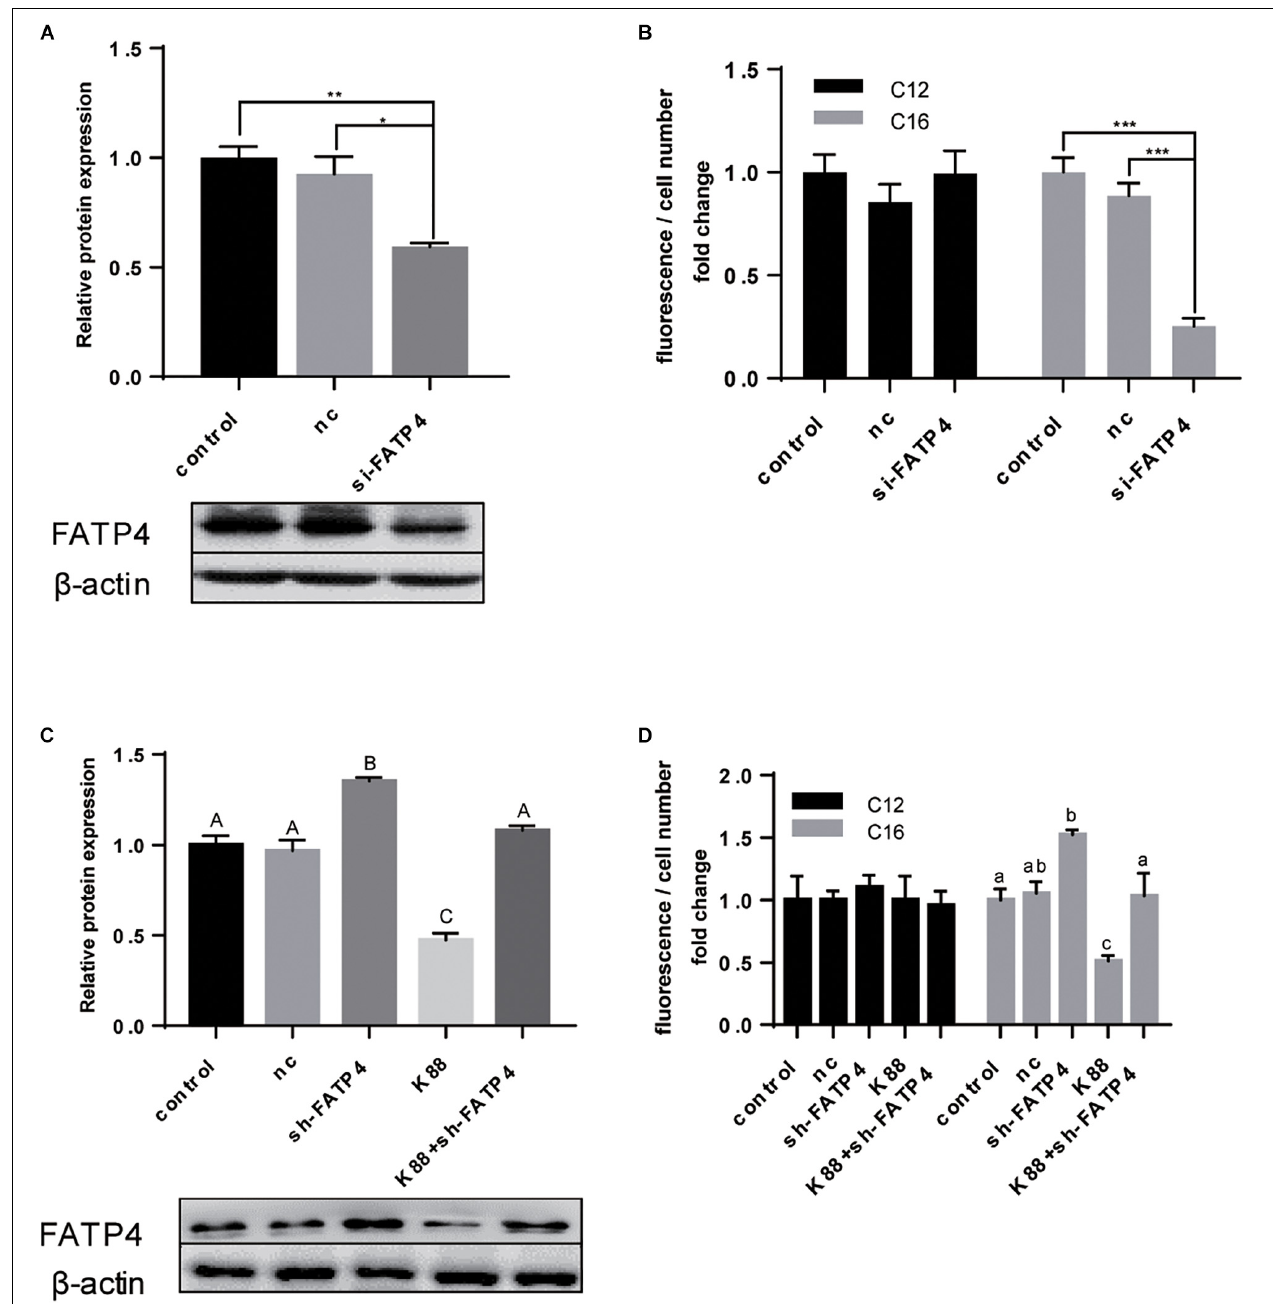
FIGURE 5 | FATP4 was dispensable in LCFA uptake of polarized IPEC-J2 cell line. (A) Western-blot analysis of FATP4 transfected with scrambled siRNA (nc) or si-FATP4 (si-FATP4). (B) Uptake of Bodipy-labeled C12:0 and C16:0 normalized by cell counting. (C) Western-blot analysis of FATP4 transfected with nc, sh-FATP4, and ETEC + sh-FATP4. (D) Uptake of Bodipy-labeled C12:0 and C16:0 normalized by cell counting. Data are presented as mean ± standard error. In (A,B) ∗ P < 0.05, ∗∗ P < 0.01, ∗∗∗ P < 0.001; in (C) values without a same superscript majuscule differ, P < 0.01; in (D) values without a same superscript lowercase differ, P <